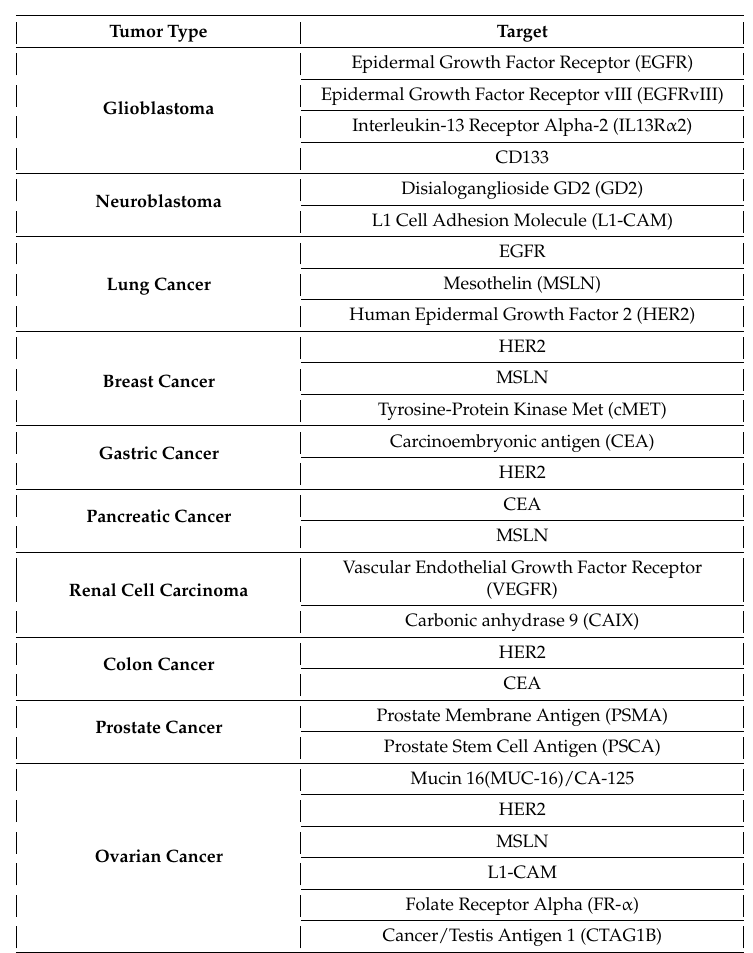
Table 2. Tumor-Associated Antigens Targeted in CAR-T Cell Therapy for Solid